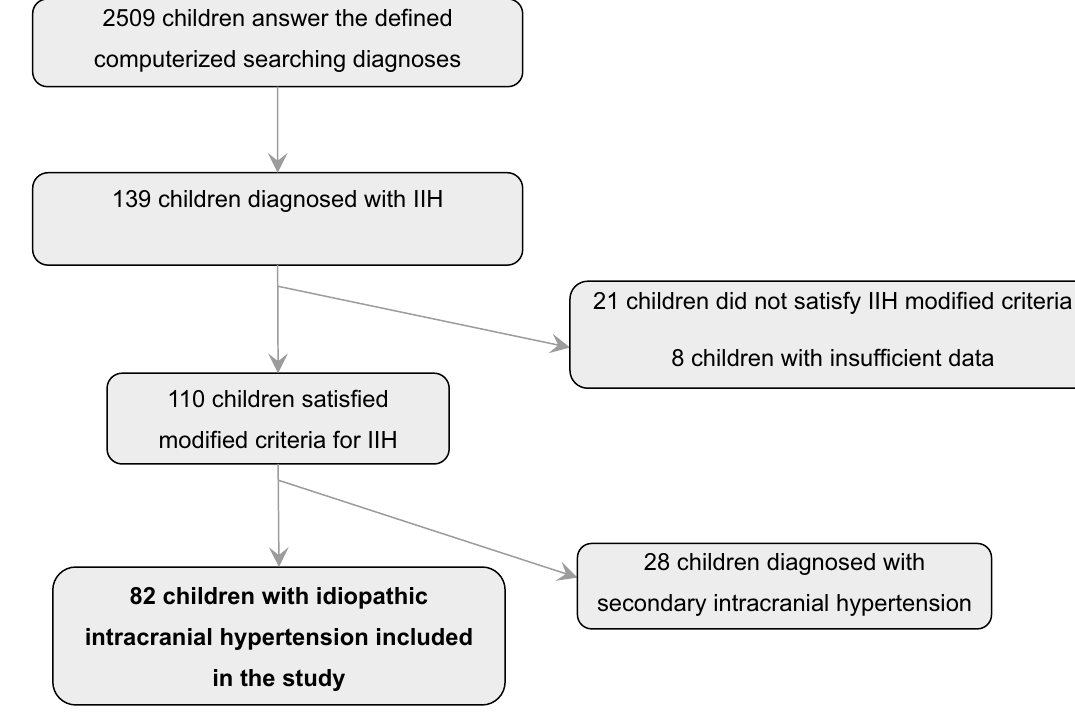
Figure 1. Study population selection flow chart. Inclusion and exclusion